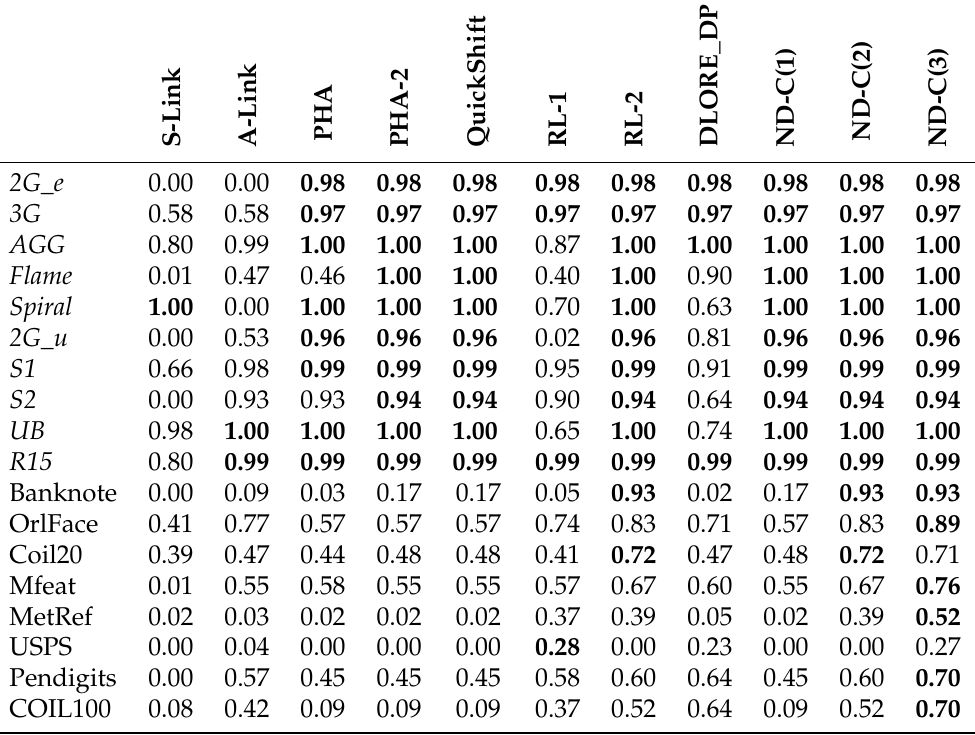
Table 4. The NMI scores of different methods on different datasets (the names of synthetic datasets are in italics). The best performance on each dataset is highlighted in